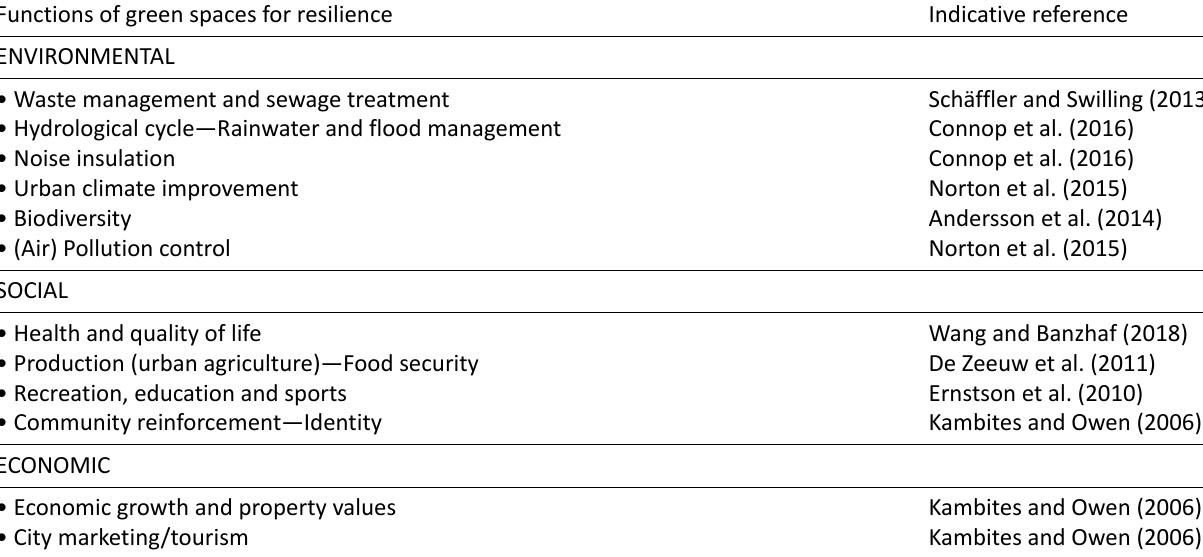
Table 1. Functions provided by GI according to the resilience literature. Functions of green spaces for resilience Indicative